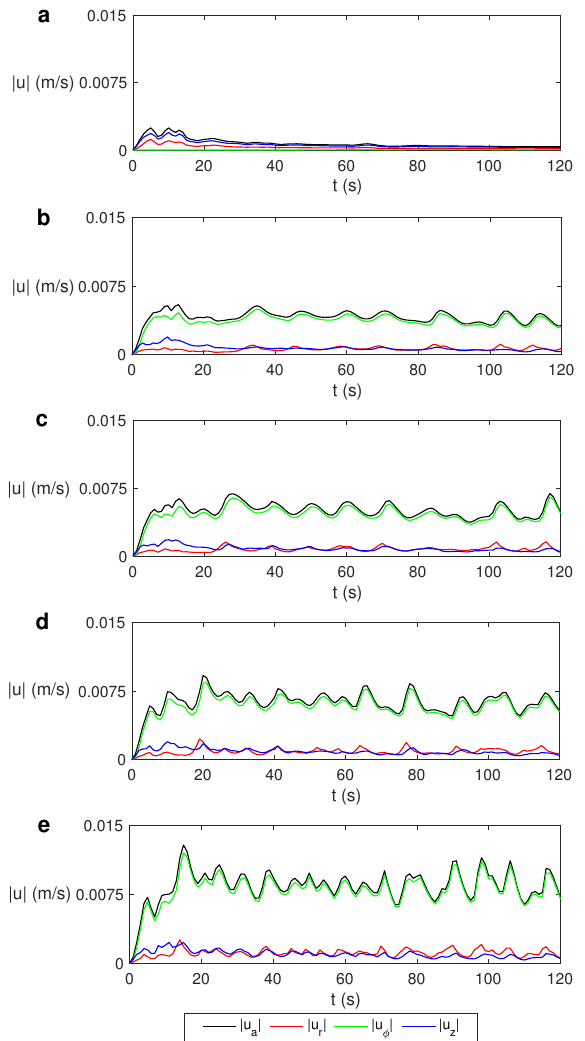
Figure 8. ( a ) Time evolution of the average velocity | u a | and the average radial ( | u r | ), azimuthal ( | u φ | ) and vertical ( | u z | ) velocity for T e = 40 ◦ C and different values of the rotation rate Ω . ( a ) Ω = 0 s − 1